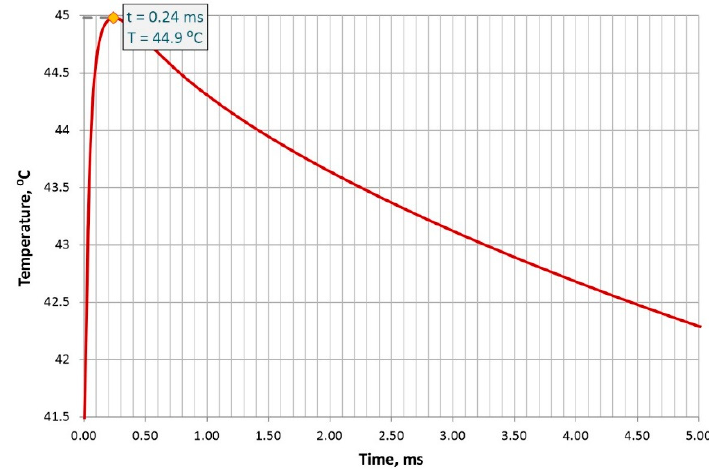
Figure 7. Simulation of temperature versus time.